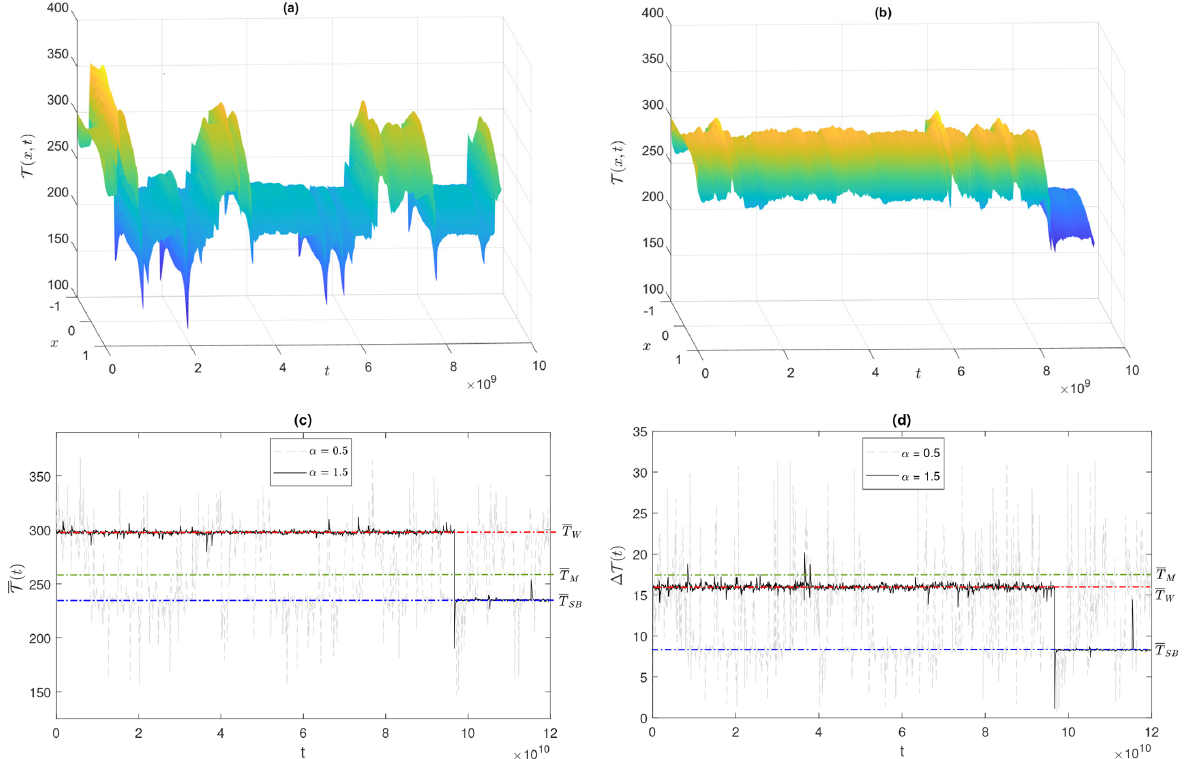
Figure 2. The metastable behaviour of the solution path of a stochastic energy balance model (Eq. 13), for ε = 0 . 04, T 0 = 300K, and t ∈ ( 0 , 300 ) years, for (a) α = 0 . 5, (b) α = 1 . 5, and the (c) temperature average T and (d) temperature contrast at low and high latitudes. (cid:49) T , for ε = 0 . 01, α = 0 . 5 , and α = 1 . 5. Red, green, or blue dash-dotted lines portray the stationary climate states of T W / T M / T SB ,